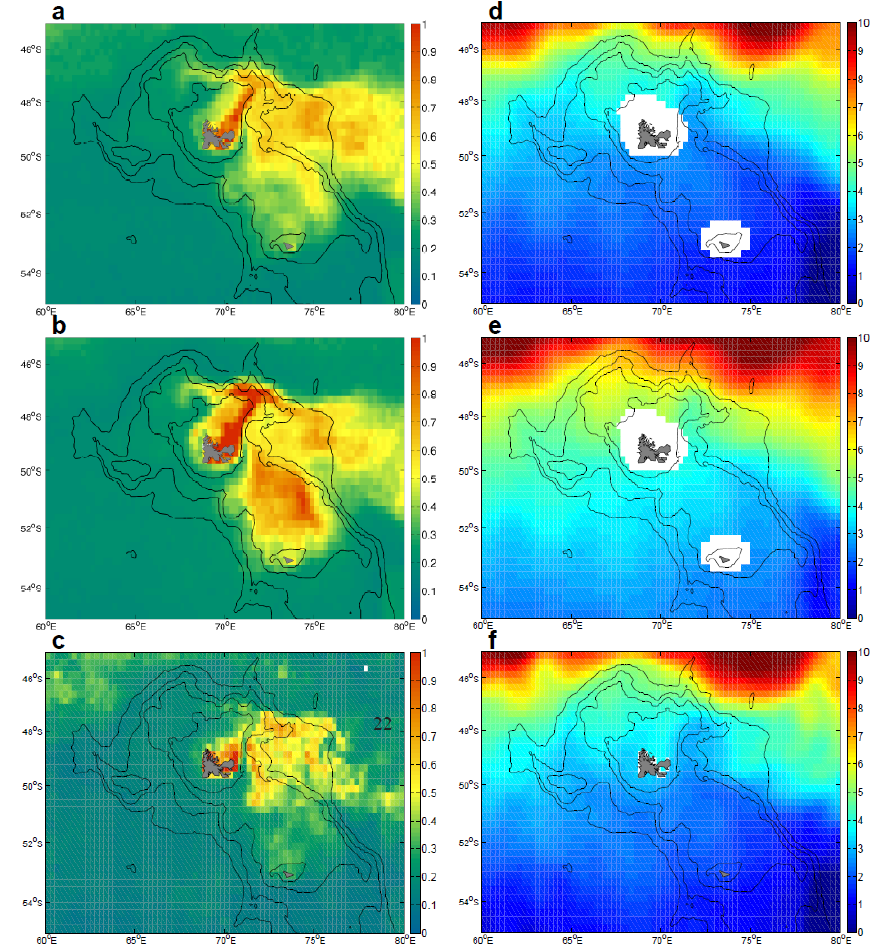
Figure 1. (a–c) Mean Chl a (in mgm − 3 ) for the Kerguelen region. (a) Climatological mean for the spring bloom, averaged over October, November, and December, 2000–2010. (b) Climatological mean for the summer bloom averaged over December, January, and February, 2000–2010. (c) Mean for the KEOPS-2 research cruise, averaged over October and November 2011. Because Chl a is lognormally distributed, here the mean is computed as exp(mean(log(Chl a ))), where log refers to the natural log and exp refers to an exponential. (d–f) Mean SST (in ◦ C) for the Kerguelen region. (d) For October, November, and December, as in (a) ; (e) for December, January, and February, as in (b) ; (f) for October and November 2011, as in (c) . In this figure and subsequent figures, bathymetry is contoured at depths of 3000, 2000, 1000, and